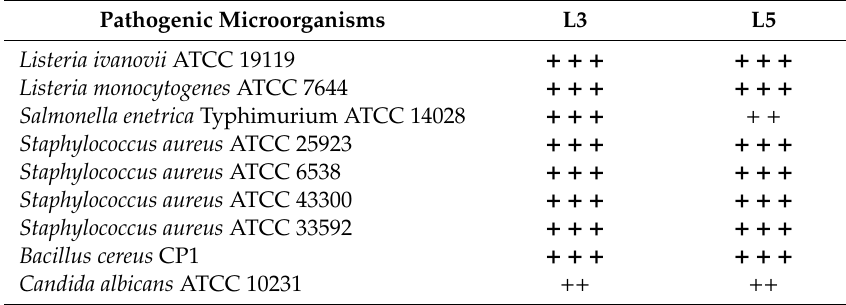
Table 4. InhibitoryactivityoflyophilizedKombuchaLABisolatesL3andL5onpathogenicmicroorganisms tested by adapted disk diffusion